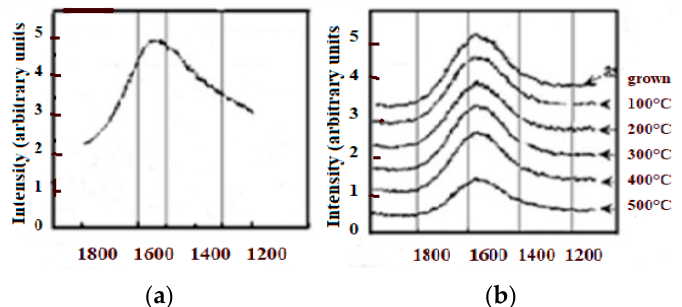
Figure 5. Raman spectra of stress shifted amorphous carbon graphitic carbon, ta-C and degraded ta-C (DLC) with no Csp2 clusters (no G sharp peak). Band max corresponding to (overlapping bands neighbor to the G peak at nominal 1580 cm − 1 ). ( a ) Tensile stress ~30 cm − 1 downshifted spectrum of amorphous graphite by Rouzaud et al. [208] by permission of the journal of Thin Solid Films. Additional dangling Csp2-Csp2 and C5 / C7 bands. ( b ) Compressive stress ~80 cm − 1 upshifted spectra of ta-C thermally degraded to less hard ta-C with reduction of stress. By Anders et al. [209] by permission of the Journal of Thin Solid Films.